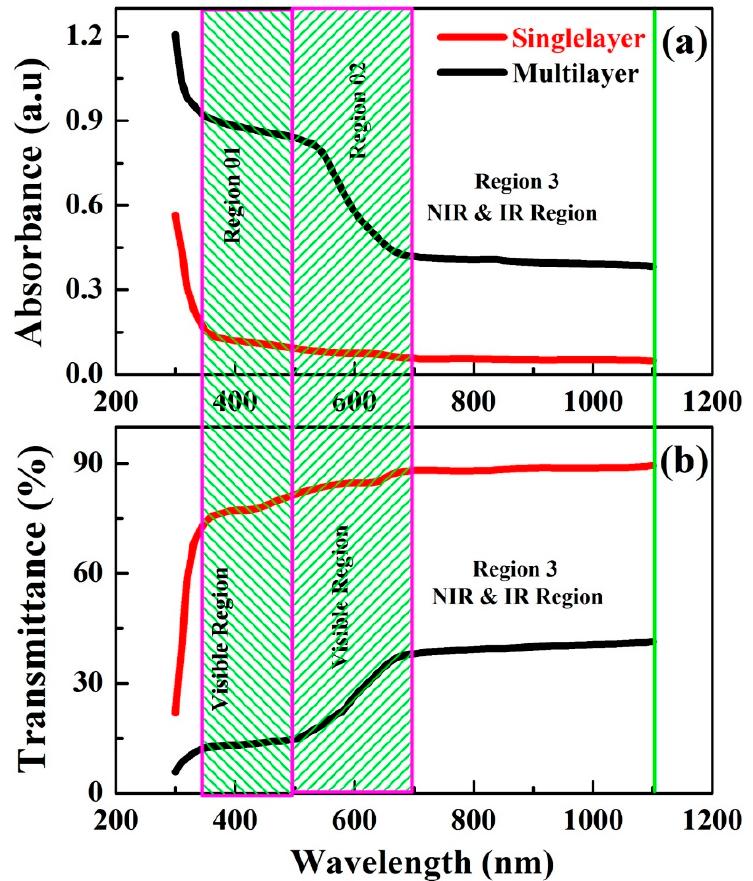
Figure 5. ( a ) Absorbance, ( b ) transmittance, spectra for single-layer and multilayered CH 3 NH 3 PbIBr 2 thinfilms.